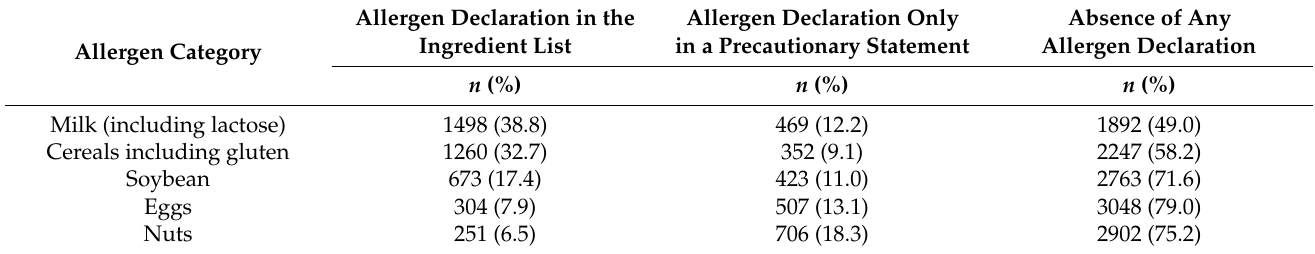
Table 2. Prevalence of products with allergen declaration for each 1 of the 14